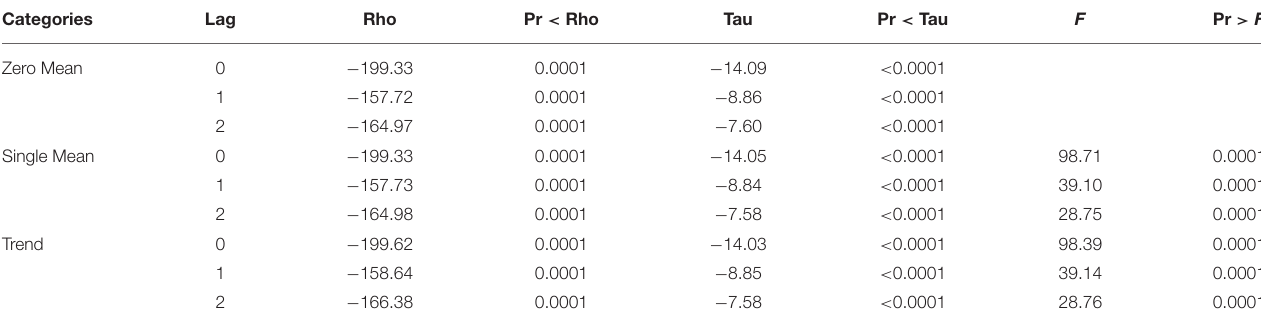
TABLE 6 | Unit Root Test Results of DSENTIMENT.